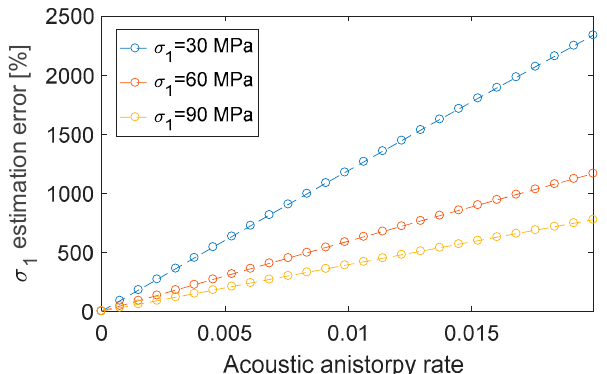
Figure 4. Stress estimation errors of the isotropic theory with respect to the anisotropy rate (Case 1A).